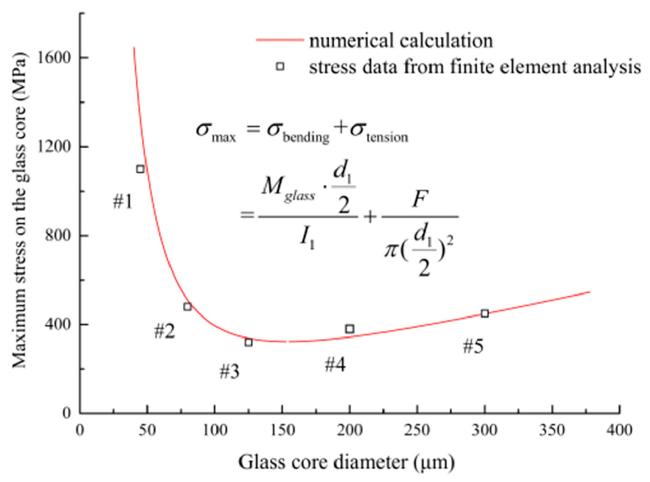
Figure 13. Maximum stress on the glass core vs. glass core diameter.